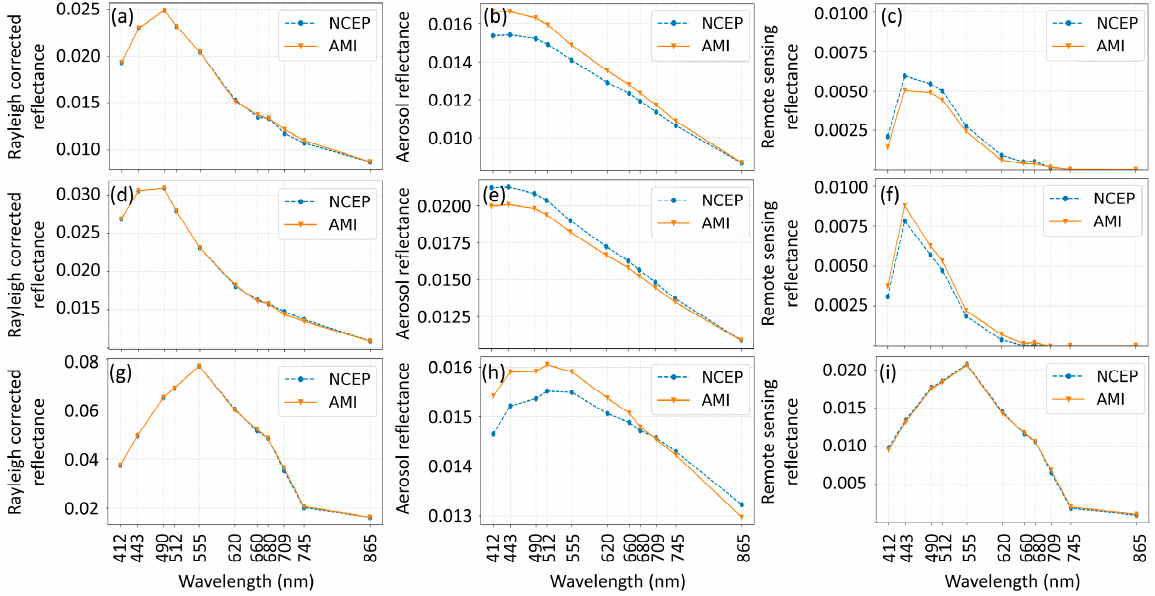
Figure 5. Spectral profiles of ( left ) Rayleigh-corrected reflectance, ( center ) aerosol reflectance, and ( right ) remote sensing reflectance for sample pixels ( a – c ) N, ( d – f ) P, and ( g – i ) T, which are indicated by stars in Figure 4. Solid orange and blue dashed lines are results obtained using AMI and NCEP TPW data, respectively.